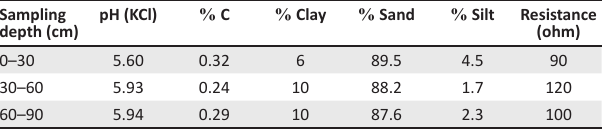
TABLE 1: Selected properties of the Hutton soil form samples collected from three depths (cm) of the soil profile at the Puntberg location in Mokala National Park. (Analyses were performed by Intertek Agricultural